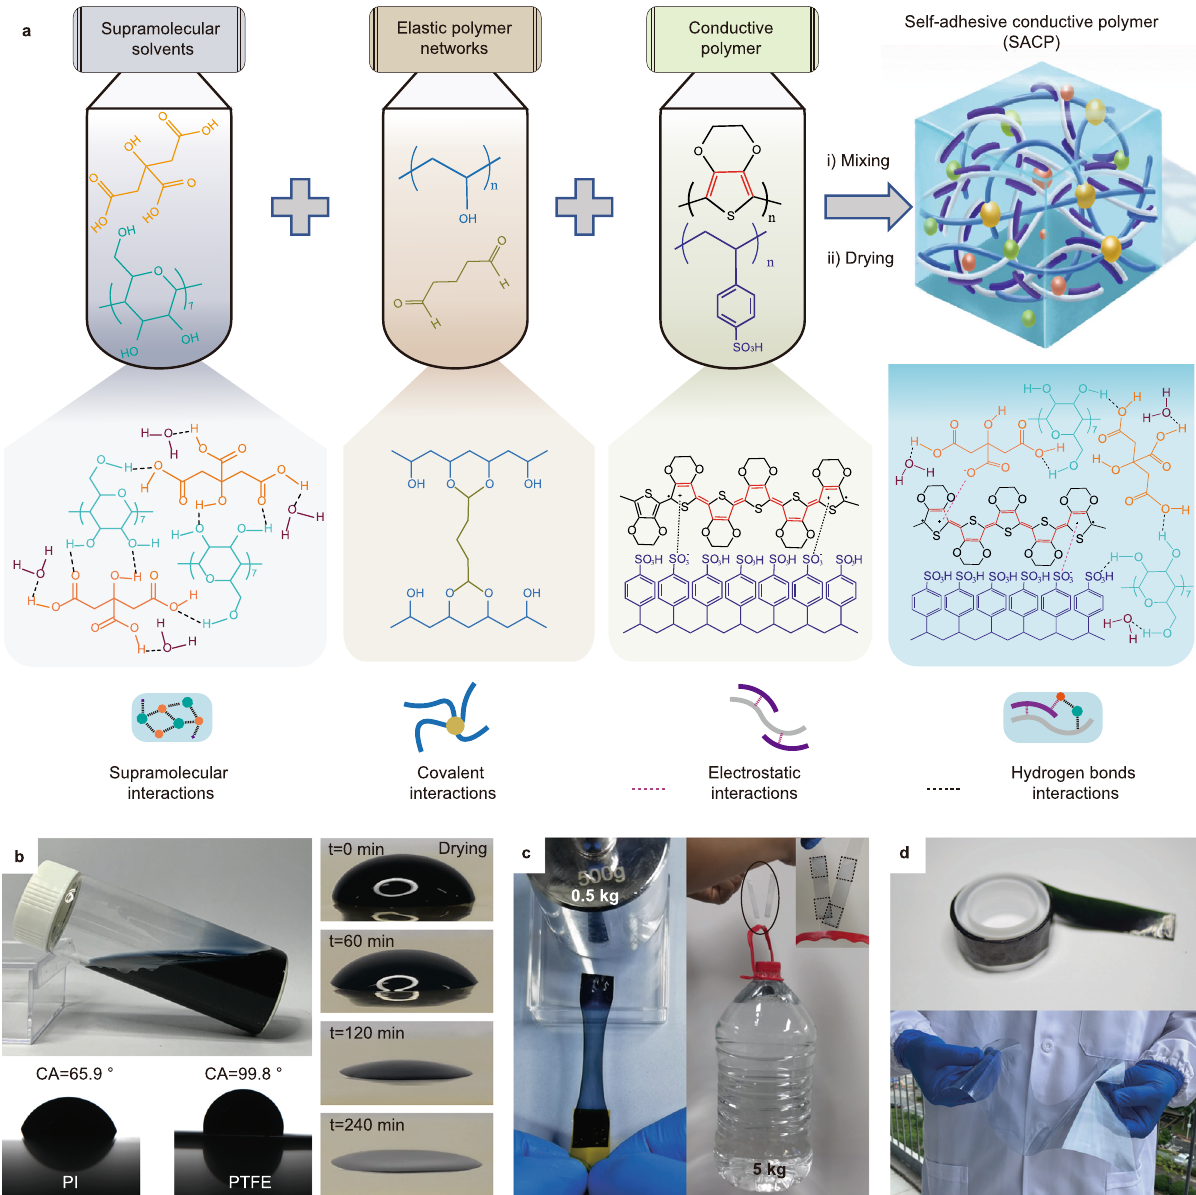
Fig. 1 Fabrication of self-adhesive conductive polymers (SACPs) with supramolecular solvent-doped PEDOT: PSS composites and demonstration of their key features. a Schematic illustration of the fabrication, molecular structures, and interactions of the SACPs, including chemical structures of PEDOT, PSS, citric acid (H3Cit), poly (vinyl alcohol) (PVA), glutaraldehyde (GA), and β -cyclodextrin ( β -CD), and the involved interactions enabled by covalently crosslinked elastic networks, electrostatic interaction, and supramolecular solvents. b Images of the aqueous SACP ink, droplets on PI (CA 65.9 o ) and PTFE (CA 99.8 o ) substrates, and the drying process of a droplet on PI substrate. No coffee ring effect is observed during the drying process. c Soft and strong adhesion by SACPs: images showing the pulling of a plastic box loading with a 0.5 kg weight (left) and the lifting of a 5 kg water bottle (right) via the SACP- based adhesives. d Large-scale application of the SACPs: images of a roll of SACP-coated PET tapes (top) and an A4 SACP-coated PET sheet (20 × 25 cm)